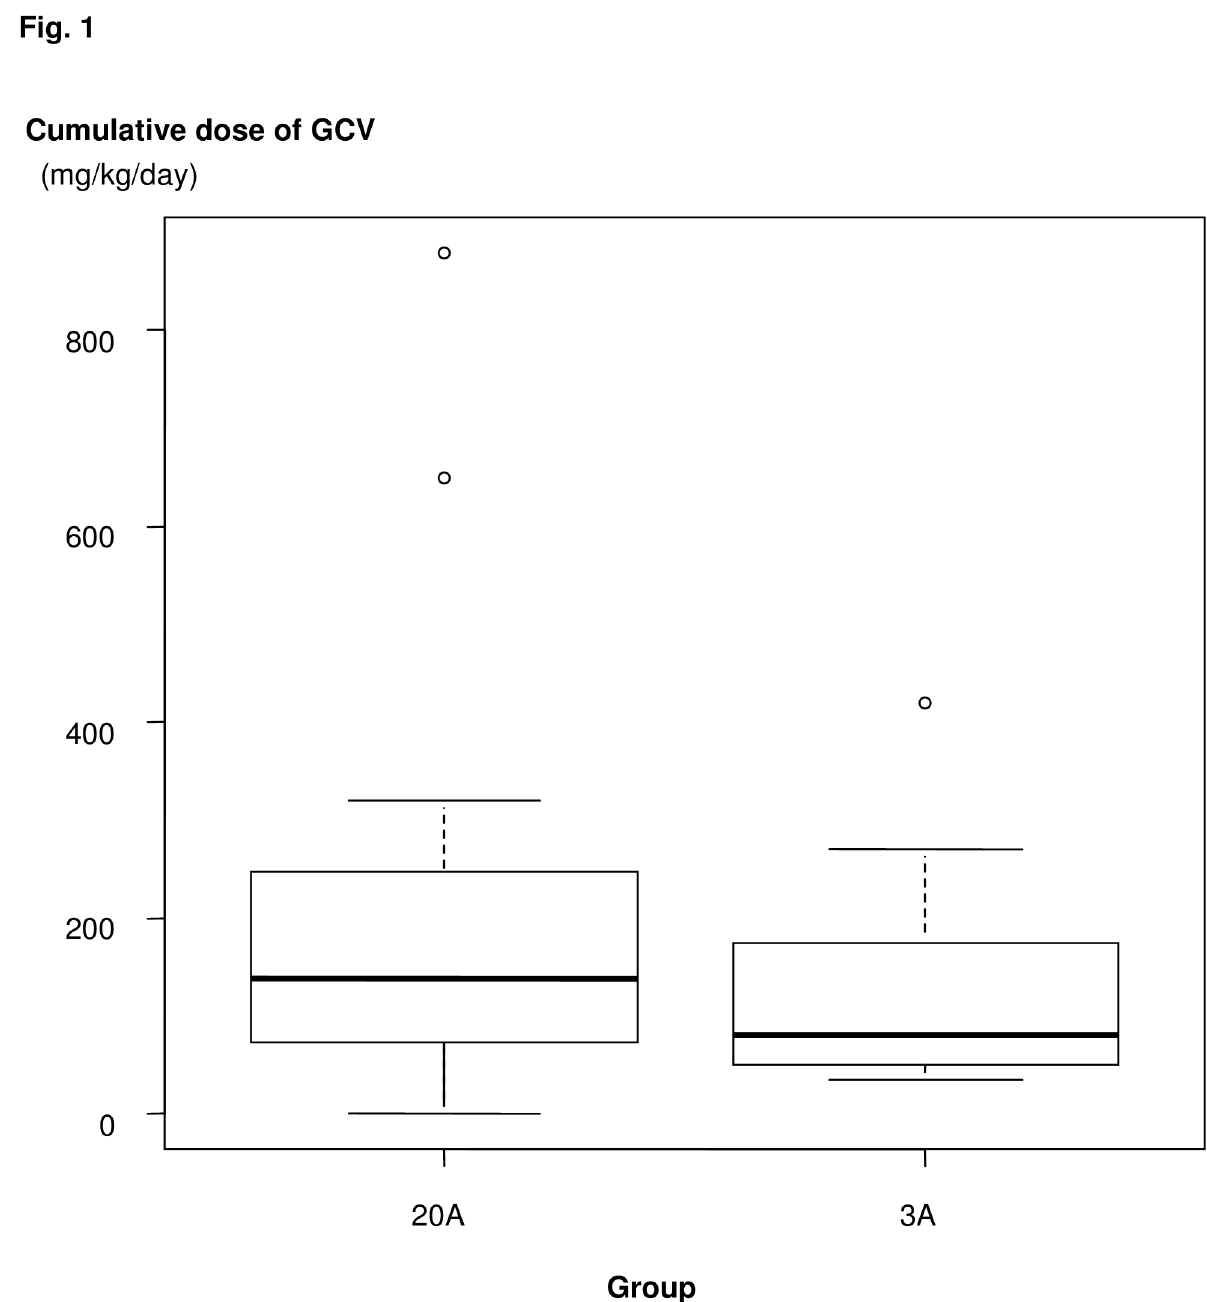
Figure 1. Cumulative dose of ganciclovir (GCV) as preemptive